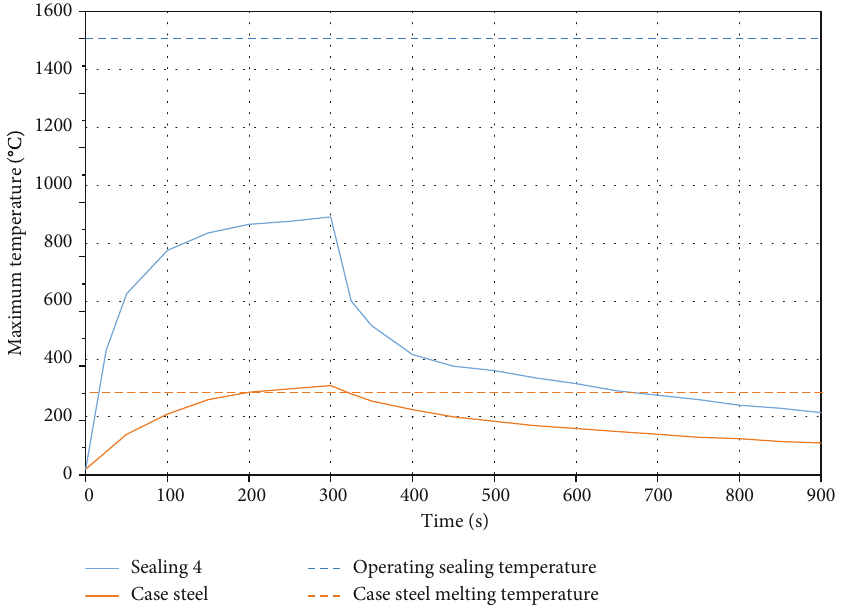
Figure 11: Dependence of maximum temperatures in material on time.